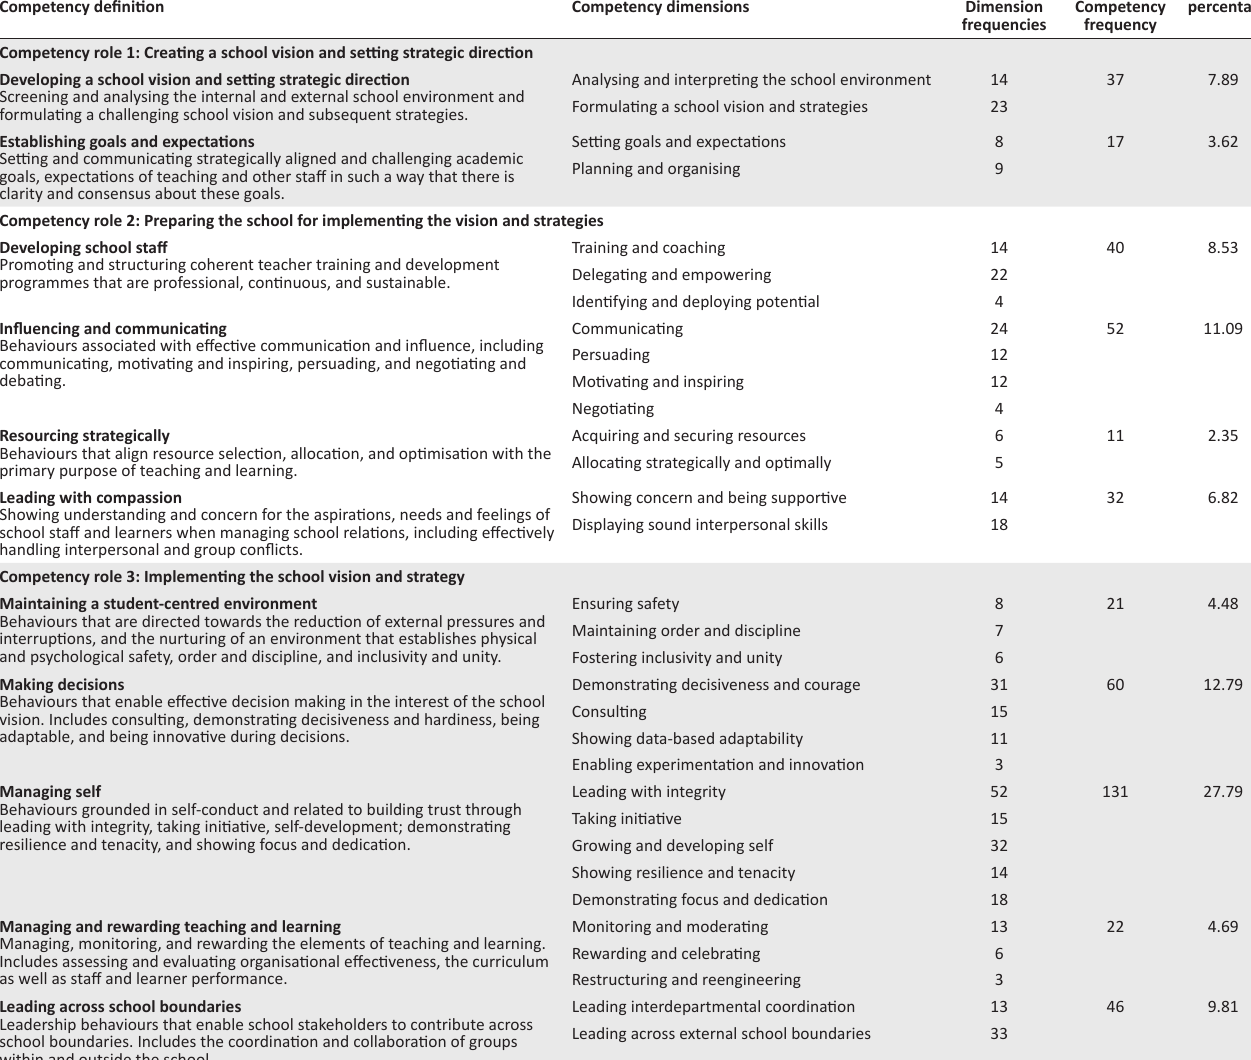
TABLE 3: Results of qualitative analysis: Competencies, dimensions and frequencies. Competency